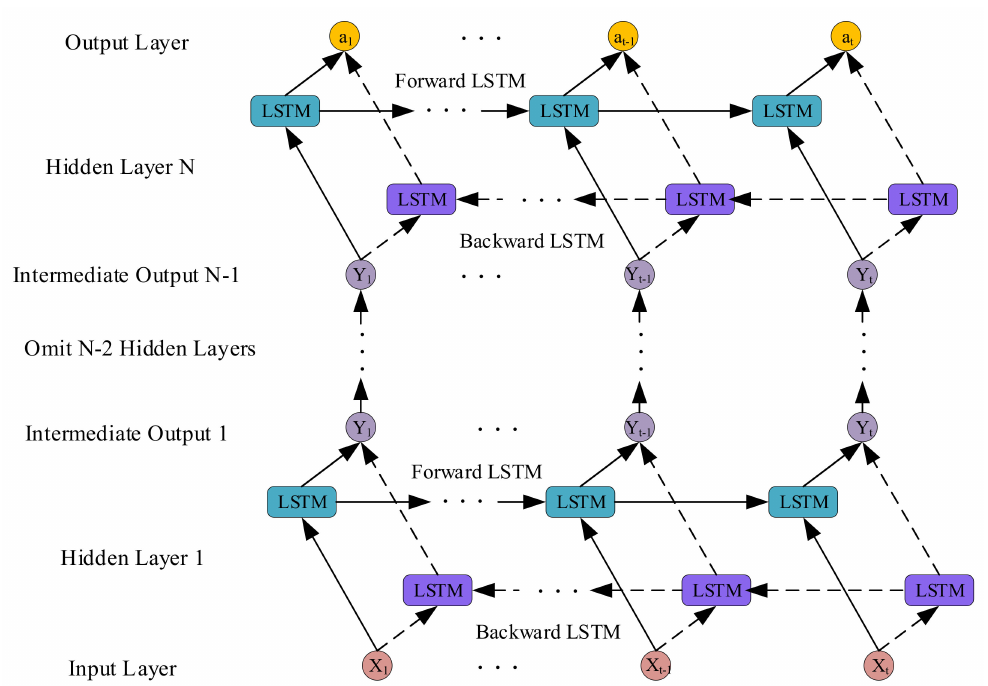
Figure 2. Structure diagram of deep bidirectional long and short-term memory (DBiLSTM) neural